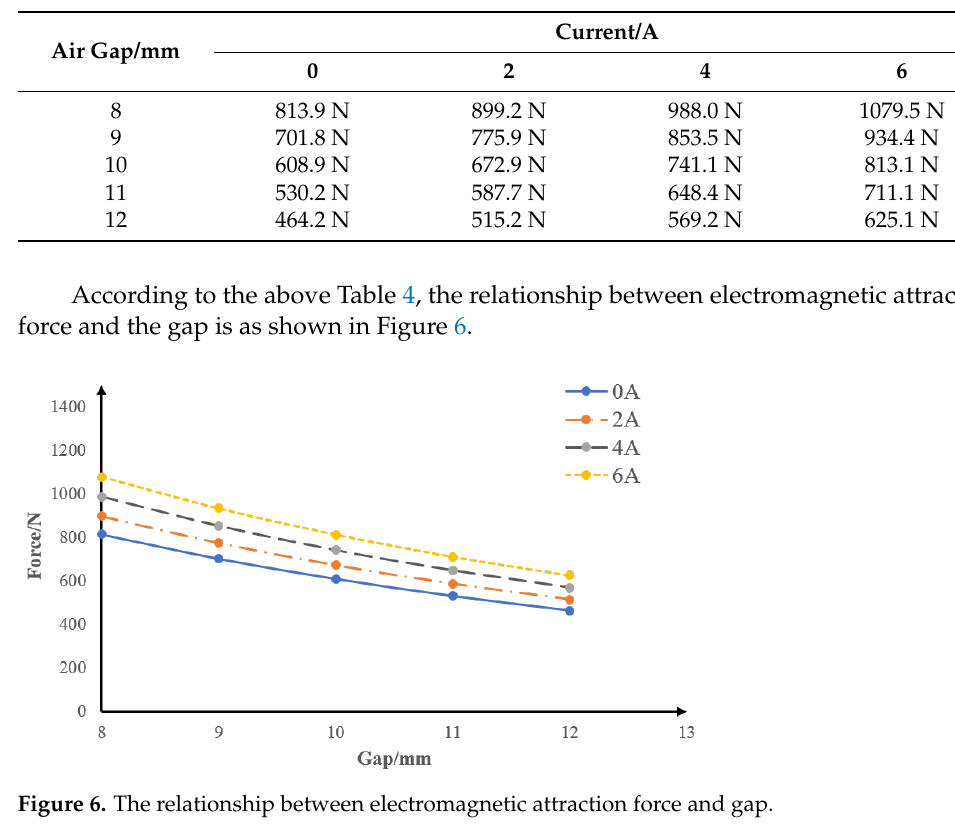
Table 4. Force of permanent and electromagnet hybrid actuator under different currents and air gaps.